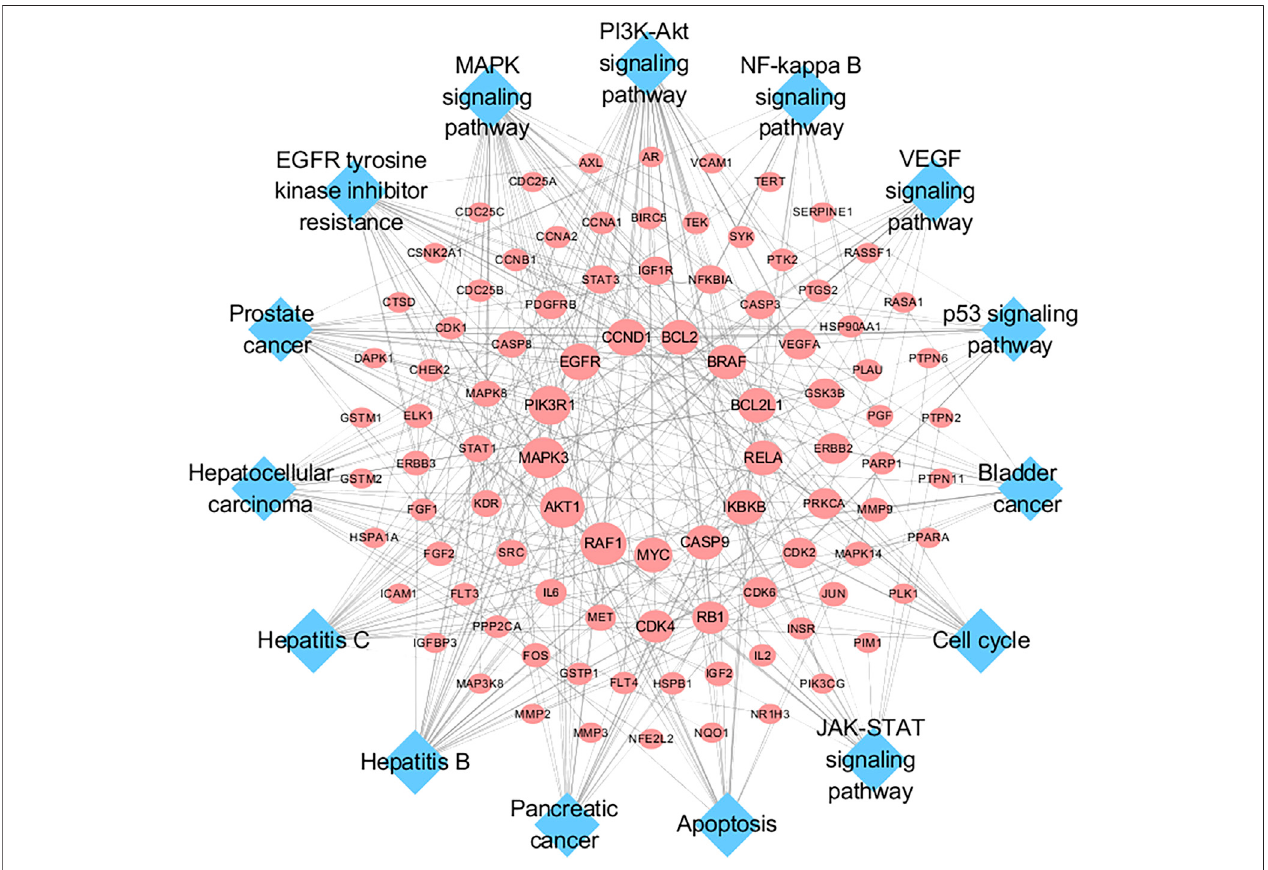
FIGURE 6 | Target-Pathway Network. The red ellipse nodes represent the target nodes. The blue diamond nodes represent the corresponding pathways.